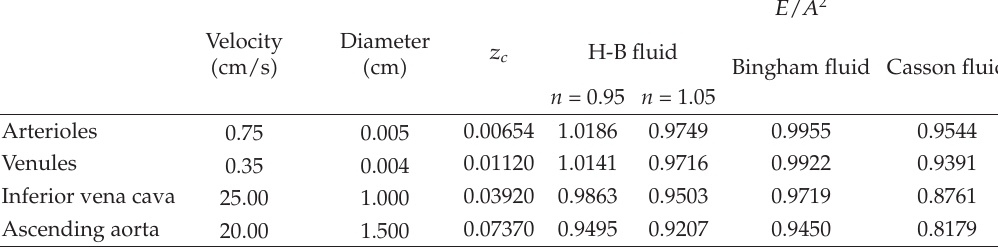
Table 1: Estimates of yield stress z c and relative di ff usivity (cid:2) E/A 2 (cid:3) in the canine vascular system for flow in tube.